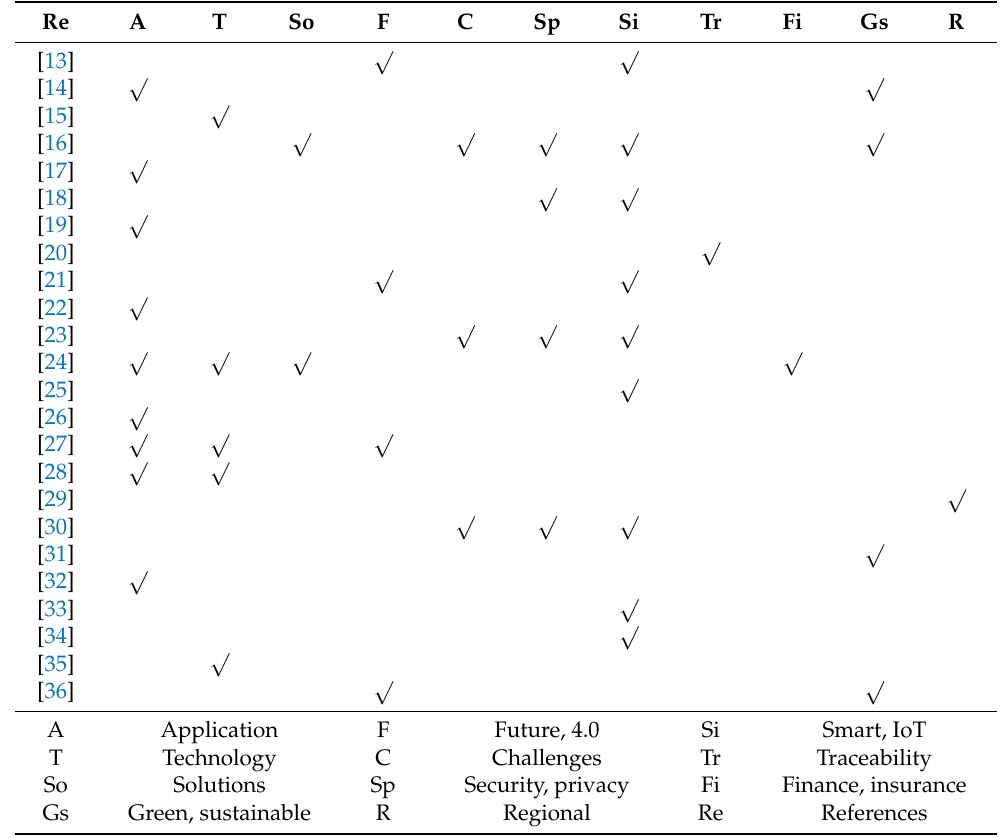
Table 2. Survey and review of blockchain in agriculture.